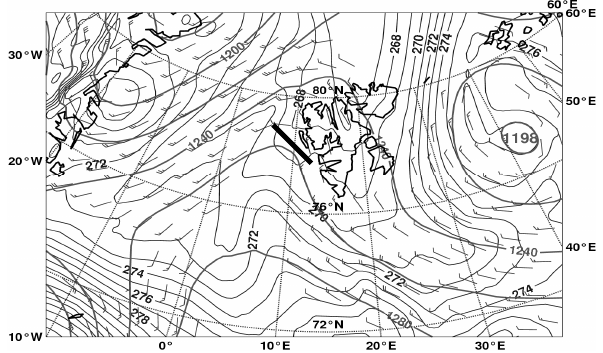
Fig. 2. Geopotential, wind vector and potential temperature fields obtained from the ECMWF analysis at 850hPa for 12:00UTC. The black line represents the airborne observation